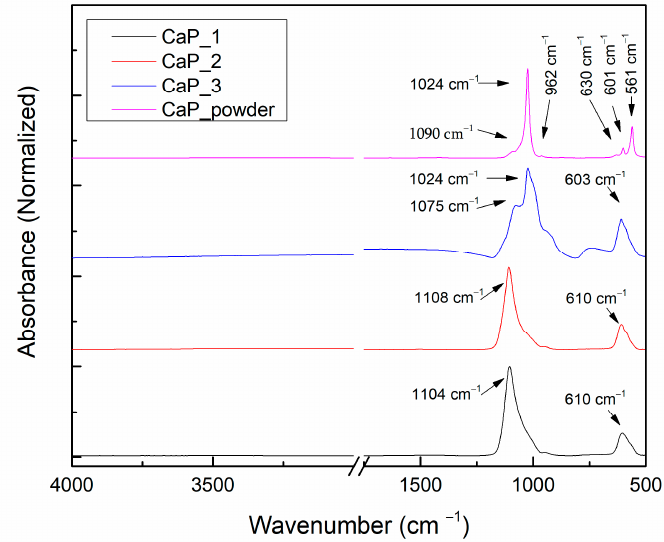
Figure 7. FTIR spectra of the CaP powder and of the CaP coatings deposited at different substrate temperatures (CaP_1, CaP_2, and CaP_3).